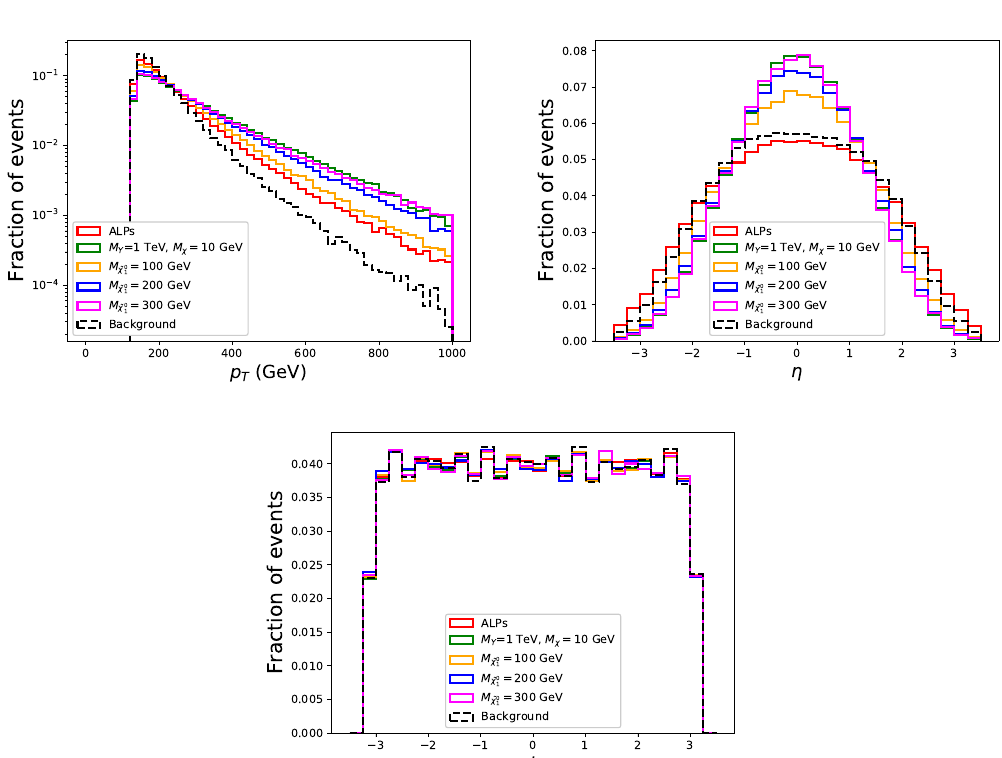
Figure 2: Monojet detector-level 1D histograms for WIMP, EFT and ALP scenarios, as well as the SM